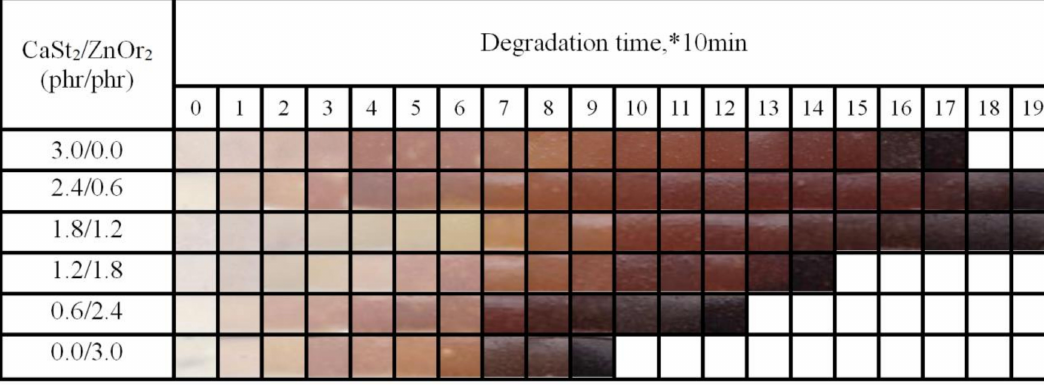
Figure 10. The effects of discoloration for PVC with different proportion of CaSt 2 /ZnOr 2 thermal stabilizers at 180 ◦ C.